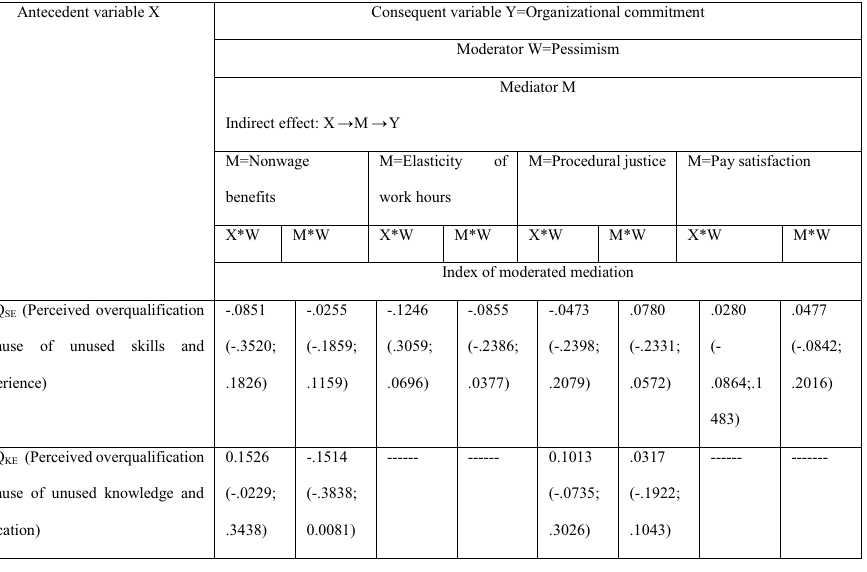
Table 8 Moderated mediation effect of Perceived overqualification (because of unused skills and experience, POQ unused knowledge and education, POQ ) on Organizational commitment ; Pessimism as a moderator KE Antecedent variable